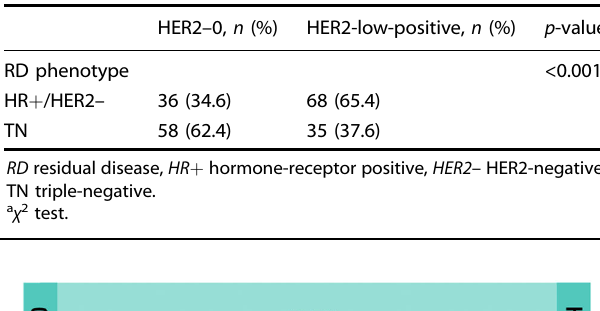
Table 4. Distribution of breast cancer phenotype on residual disease according to HER2 expression.